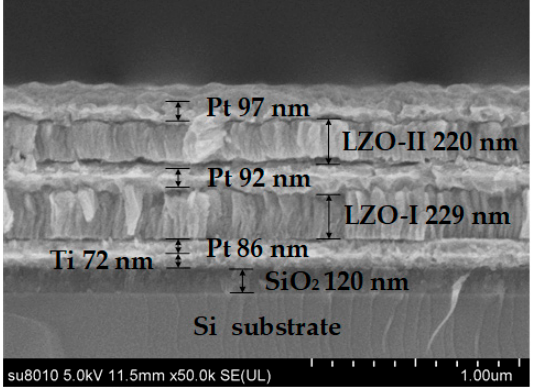
Figure 8. Atomic force microscopy (AFM) images of the LZO thin film: ( a ) Surface morphology; ( b ) 3D surface topography.